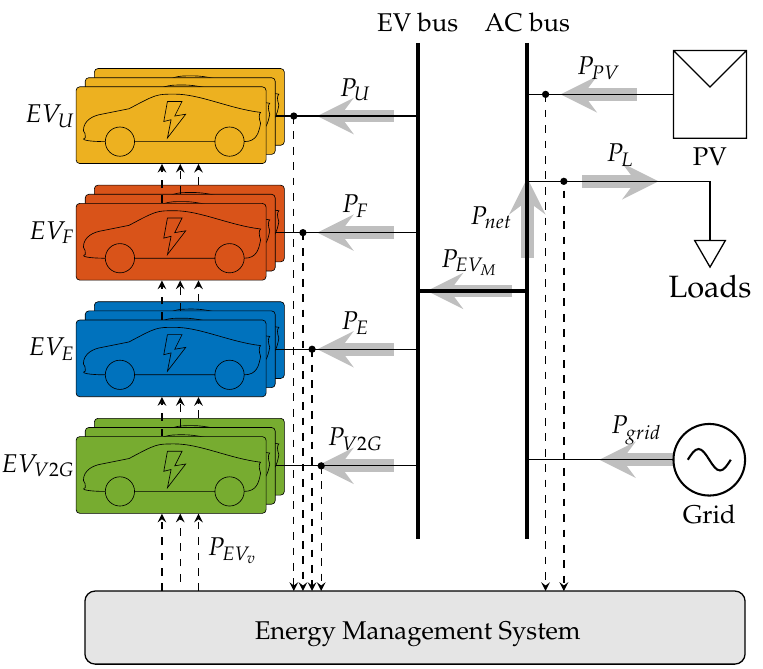
Figure 3. Simplified arrangement of the proposed microgrid.